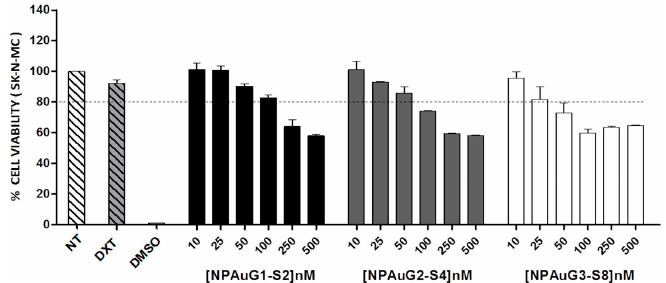
Figure 2. Cytotoxicity associated with NPAus in SK-N-MC human neuroepithelioma cell lines at 24 h post-treatment using MTT assay. SK-N-MC cells were treated with increasing concentrations of gold NPs from 10 nM to 500 nM. SK-N-MC cells were not treated as control of viability or treated with 10% of DMSO as control of cell death. The percent of cell viability was calculated as optical density. The 80% of viability was set asa limit of toxicity. Data are represented as mean ± SD of three experiments performed in triplicate. Abbreviations: NT= non-treated; DXT= Dextran; DMSO= dymethyl sulfoxide.